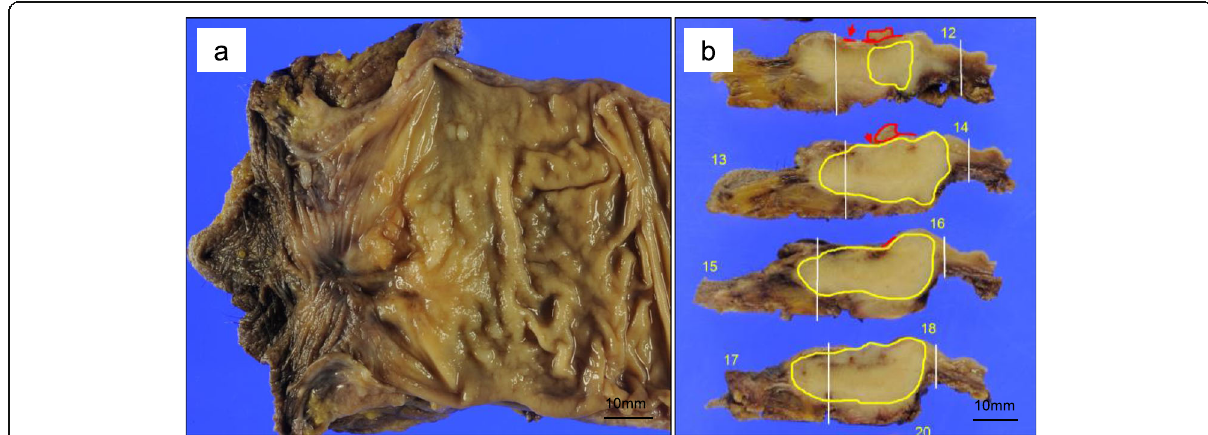
Fig. 4 Depressed and protruding lesions were found from the proximal anal canal to the anal verge macroscopically. a The surface was a gray- white mass from the submucosa to the adventitia. b Area surrounded by the red line delineates the well-differentiated adenocarcinoma